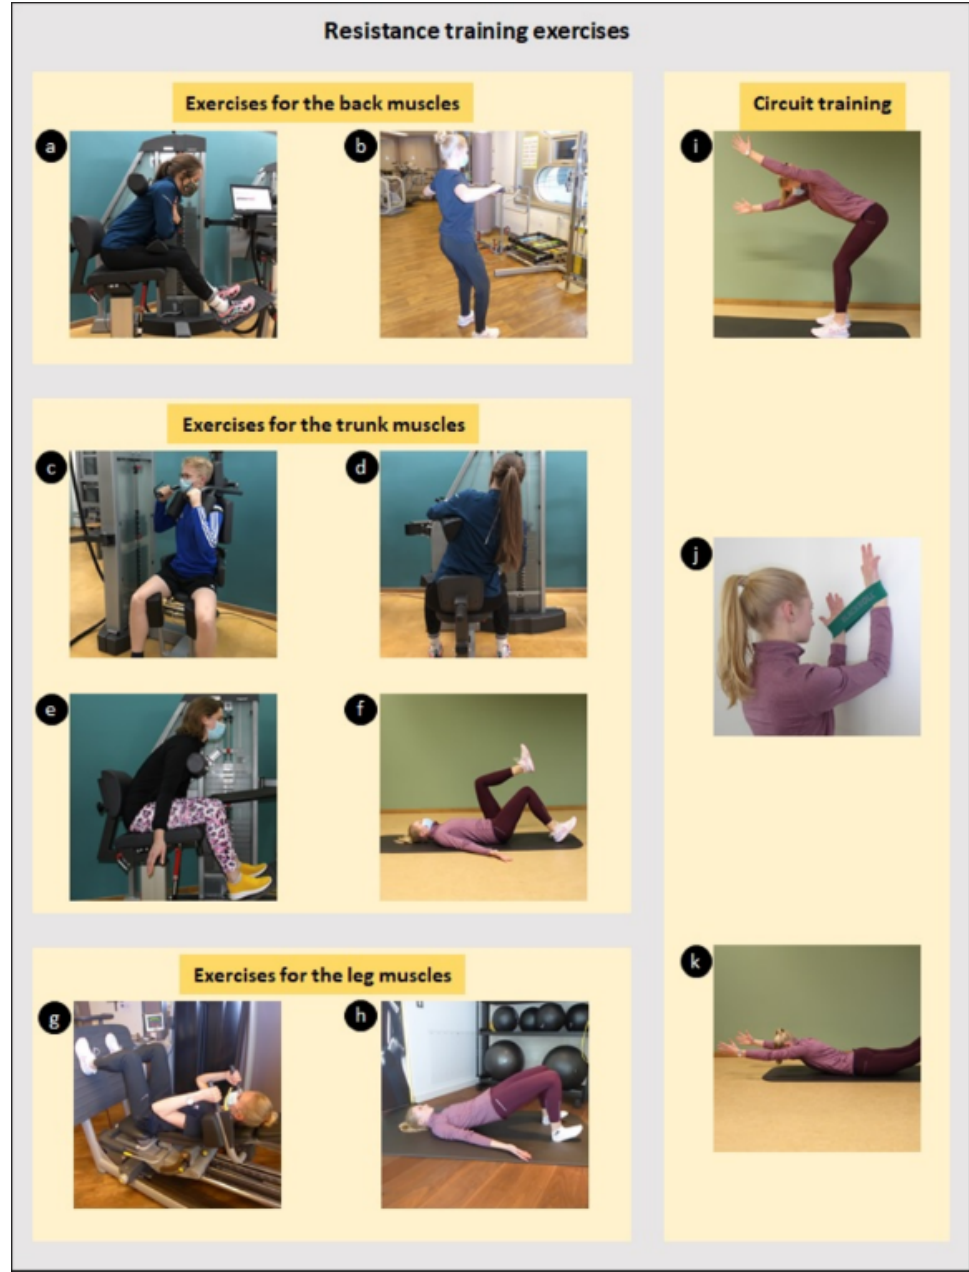
Figure 1. Exercises of the resistance training programme: ( a ) back extension, ( b ) wide rowing, ( c ) trunk rotation, ( d ) lateral flexion of the trunk, ( e ) trunk flexion, ( f ) dead bugs, ( g ) leg press, ( h ) glute bridge, ( i ) arm wiggles, ( j ) wall walk and ( k ) superman.